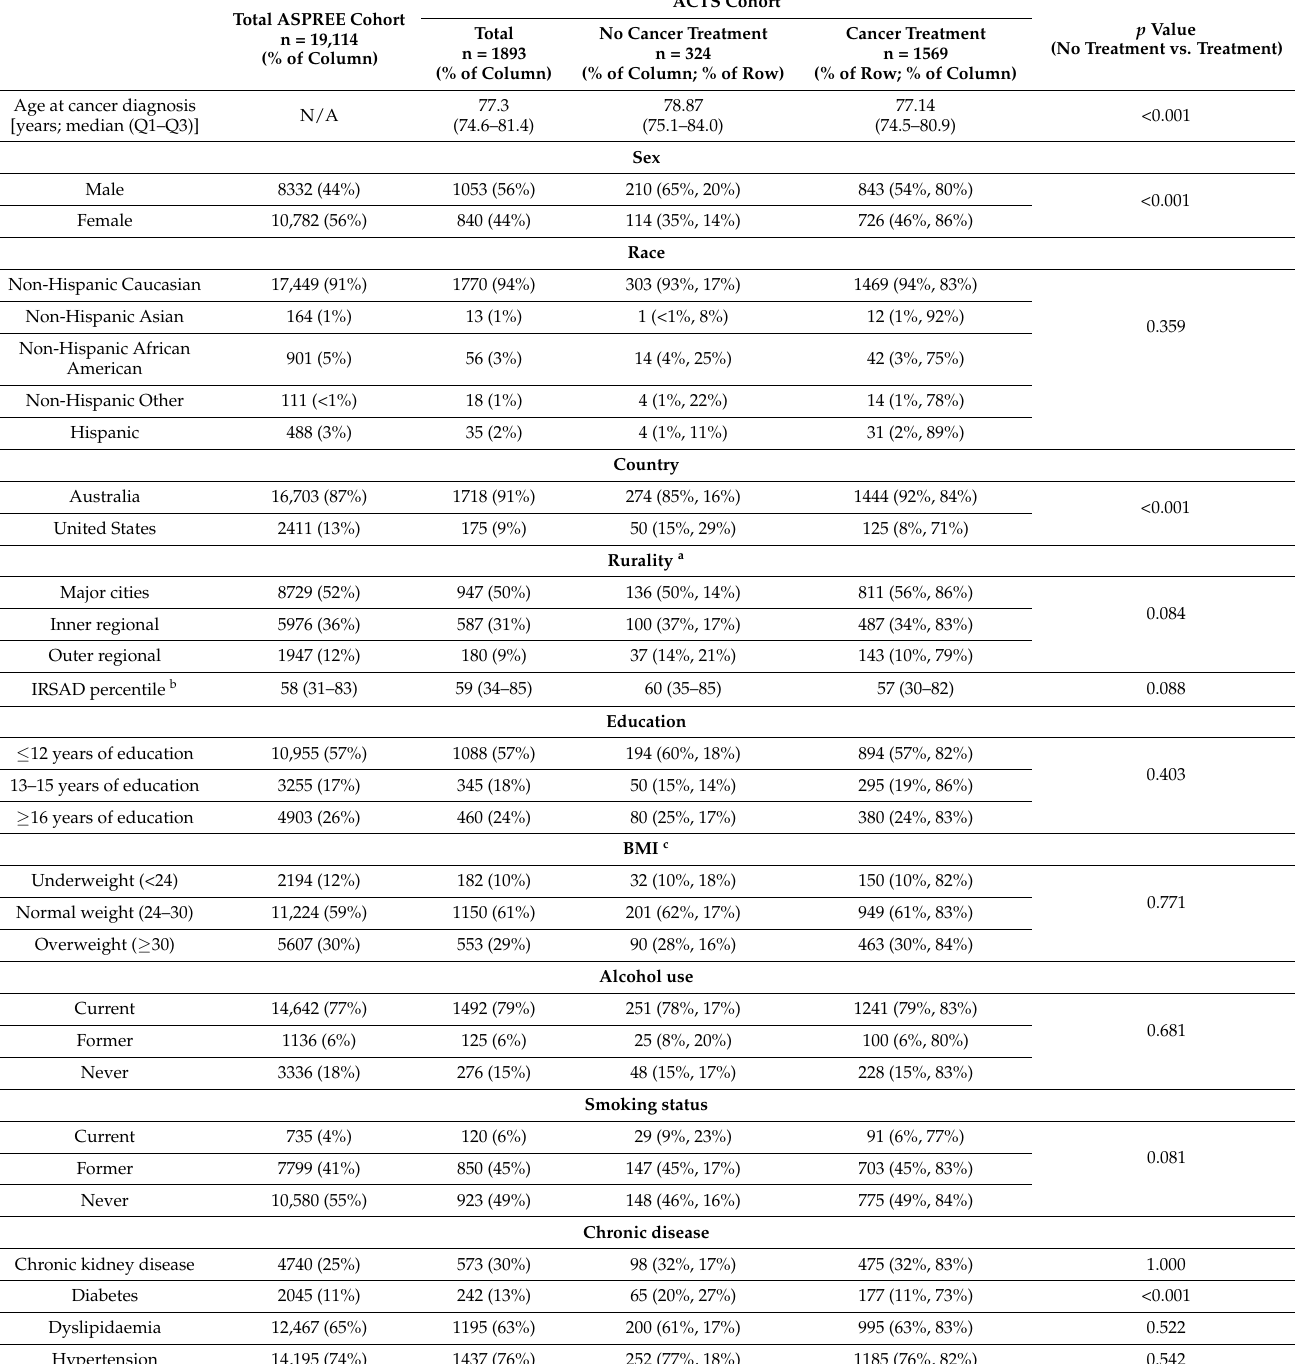
Table 1. Participant demographics and characteristics of the total cohort, as well as stratification by incident (first) post-randomisation cancer diagnosis and receipt of cancer